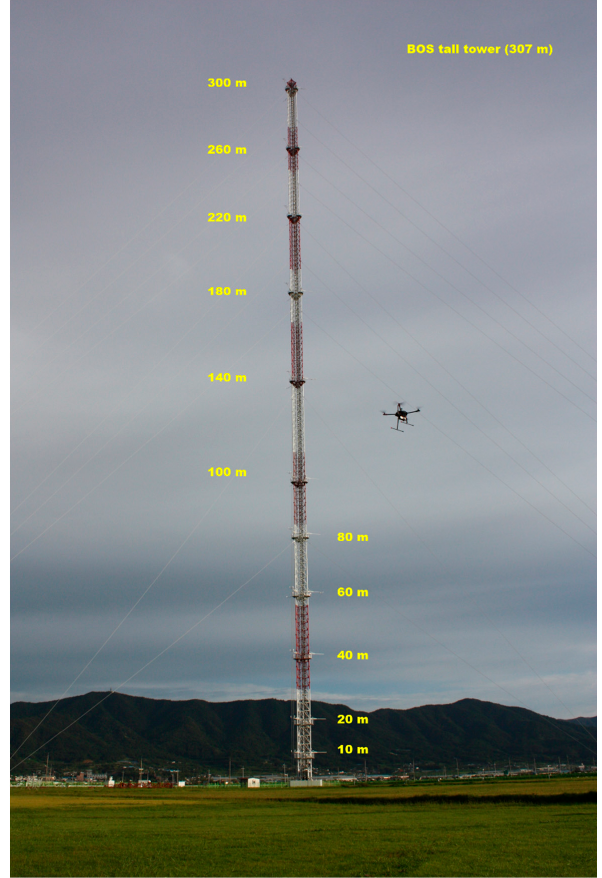
Figure 5. Rotary-wing UAV using a local coordinate system at the BOS observatory. The roll, pitch, and yaw angles are the rotations about the X, Y, and Z axes, respectively.